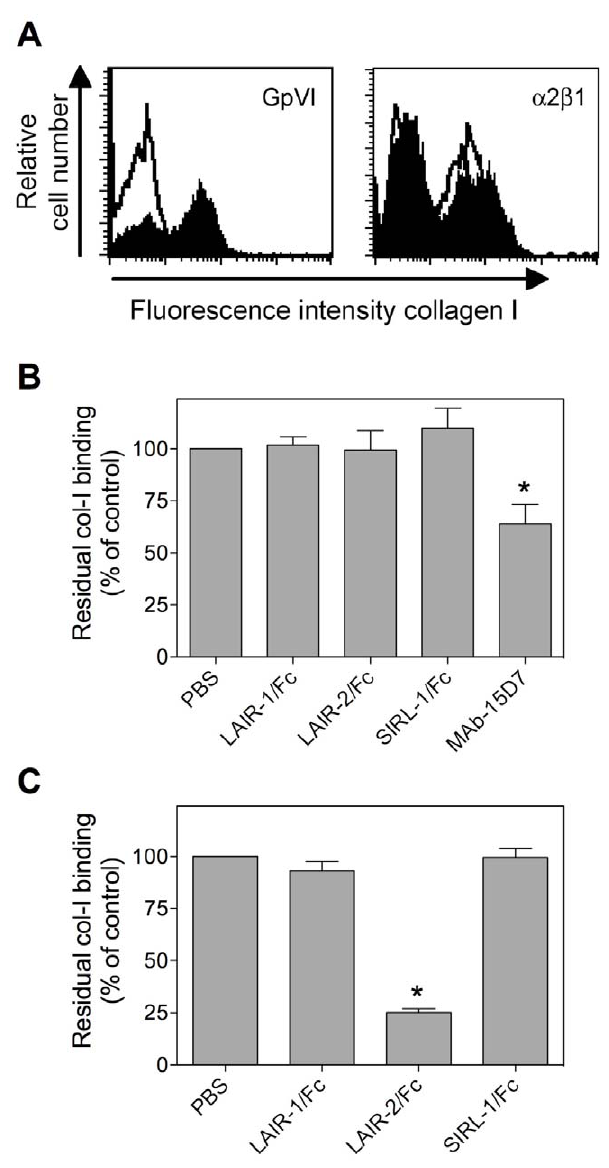
Figure 4. LAIR-2/Fc interferes with GpVI but not a 2 b 1 binding to collagen. Jurkat-cells expressing GpVI or CHO-cells expressing a 2 b 1 (Mn 2 + activated) were incubated with FITC-labeled collagen I (7.7 m g/ ml) in the absence or presence of 0.5 mg/ml LAIR-1/Fc, LAIR-2/Fc or SIRL-1/Fc. Residual collagen binding was subsequently analyzed via FACS-analysis. Panel A: representative histograms for binding of FITC- labeled collagen I to GpVI- or a 2 b 1-expressing cells in the absence (closed histograms) or presence (open histograms) of LAIR-2/Fc. Panel B: Quantitative analysis of residual FITC-labeled collagen I binding to a 2 b 1-expressing cells in the absence or presence of Fc-fusion proteins or the blocking a 2 b 1 antibody MAb-15D7. Panel C: Quantitative analysis of residual FITC-labeled collagen I binding to GpVI-expressing cells in the absence or presence of Fc-fusion proteins. Data represent the relative mean fluorescent intensity (expressed as % of PBS control) 6 SD of three independent experiments. * p , 0.005 compared to control.